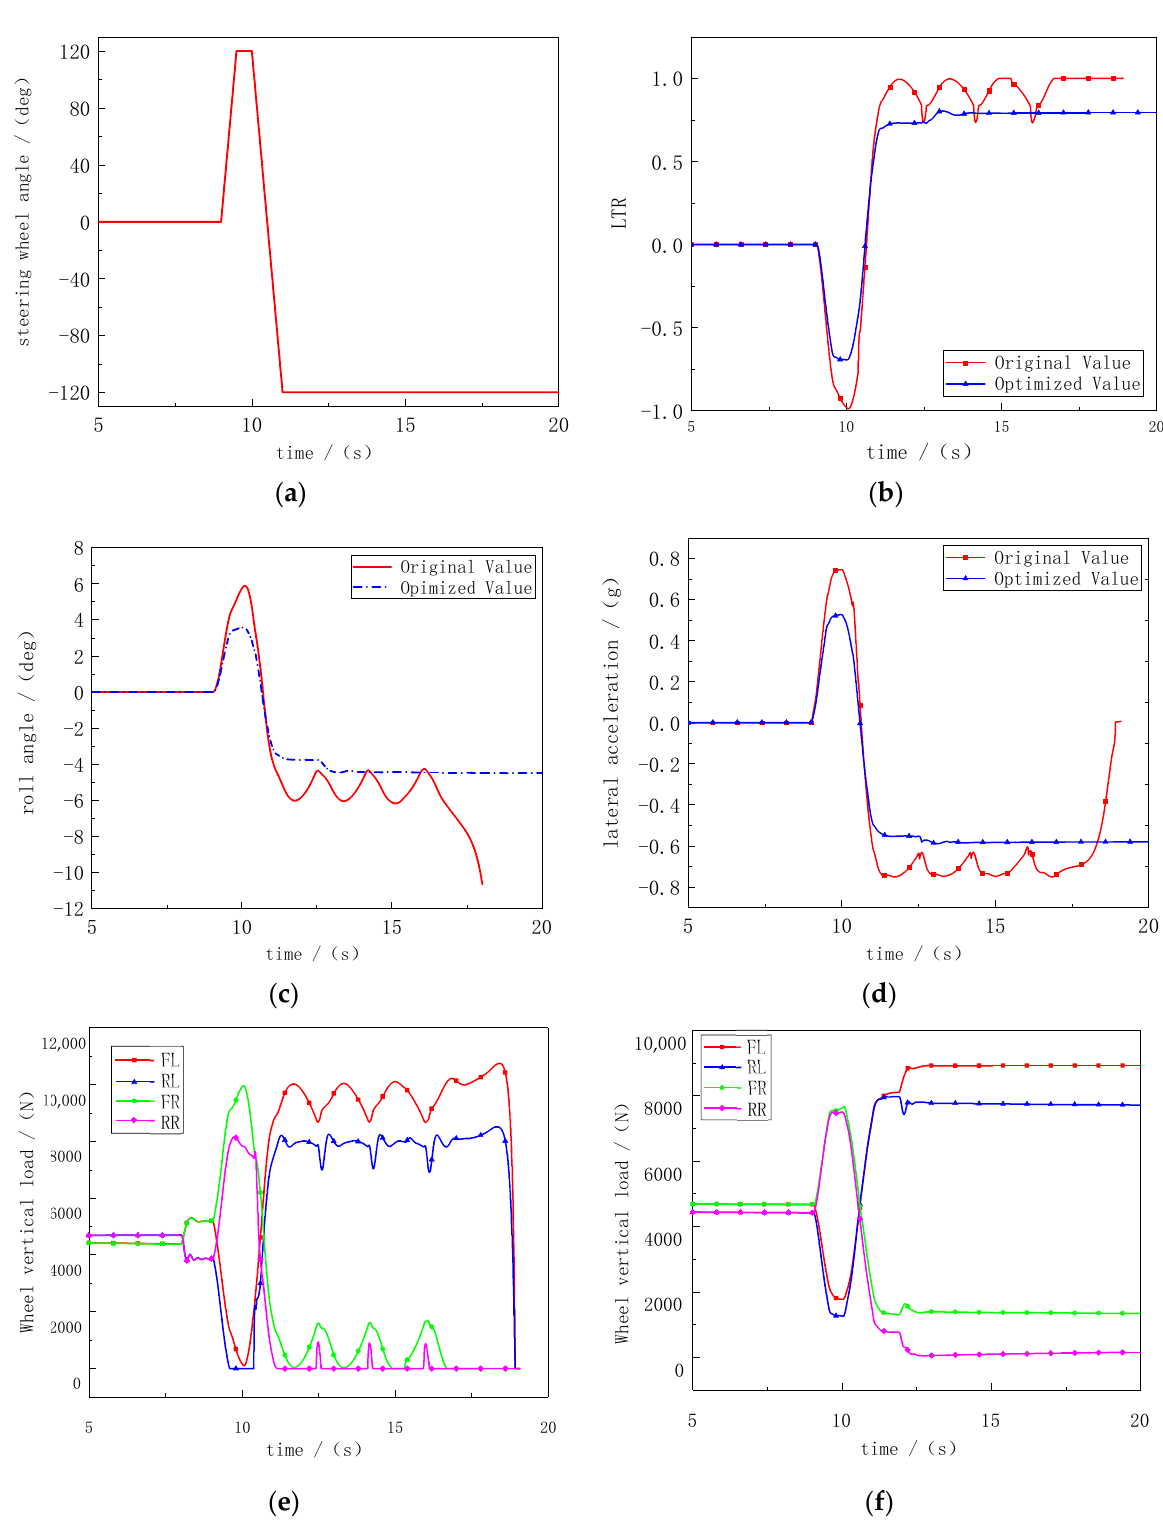
Figure 9. Simulation results of fish hook test condition. ( a ) Steering wheel angle. ( b ) LTR. ( c ) Lateral acceleration. ( d ) Roll angle. ( e ) Wheel vertical load before control. ( f ) Wheel vertical load after control.